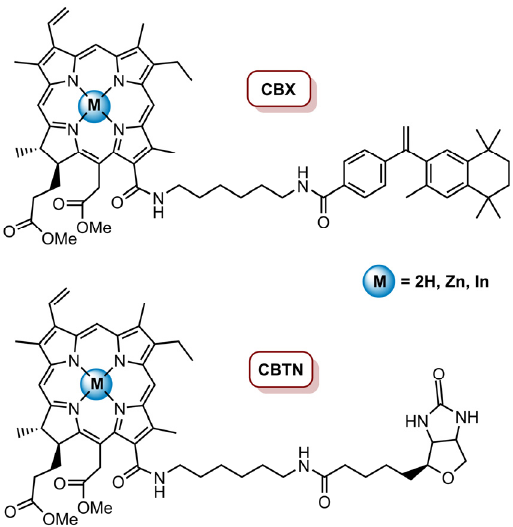
Figure 11. Transporter-targeted drug delivery systems, CBX and CBTN, and their corresponding Zn(II) and In(II) complexes.